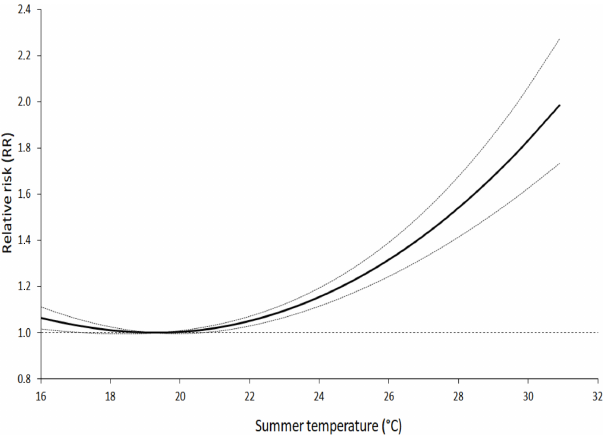
Figure 6. Relative risk (RR) curve based on mortality due to sum- mer daily temperature (JJA) in Barcelona for the 1980–2015 period (Achebak et al., 2018). Table 3. Temperature thresholds associated with heat exposure caused by high temperatures in reference to Fig. 5. A heat expo- sure index (HEI) is assigned to each temperature